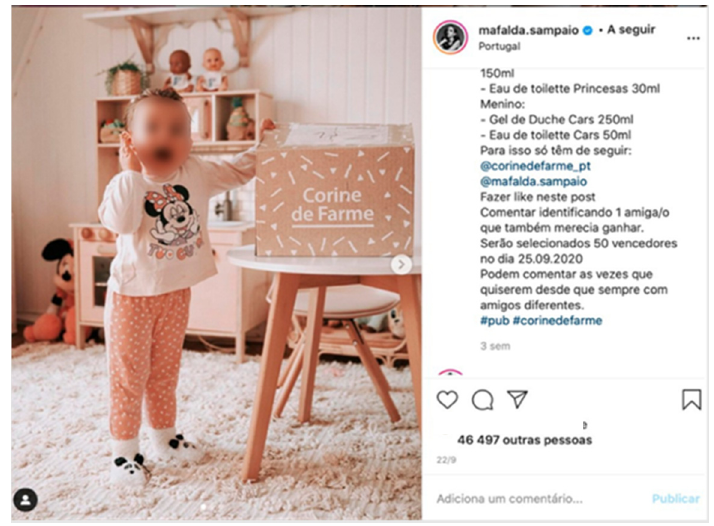
Figure 3. Example of “Special Events”; Instagram @diogoamaral.official, Post, 8 April 2020.